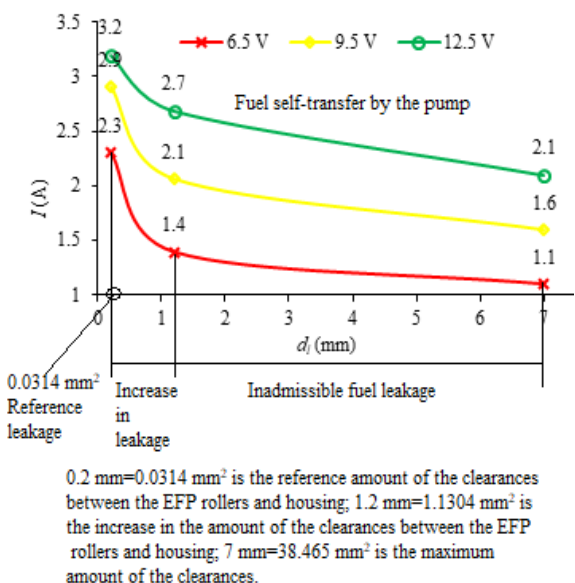
Figure 2. Regularities of changes in the current rate I depending on the diameter of the fuel supply line section d s (modelling of the filter element clogging I=f((cid:31)) )